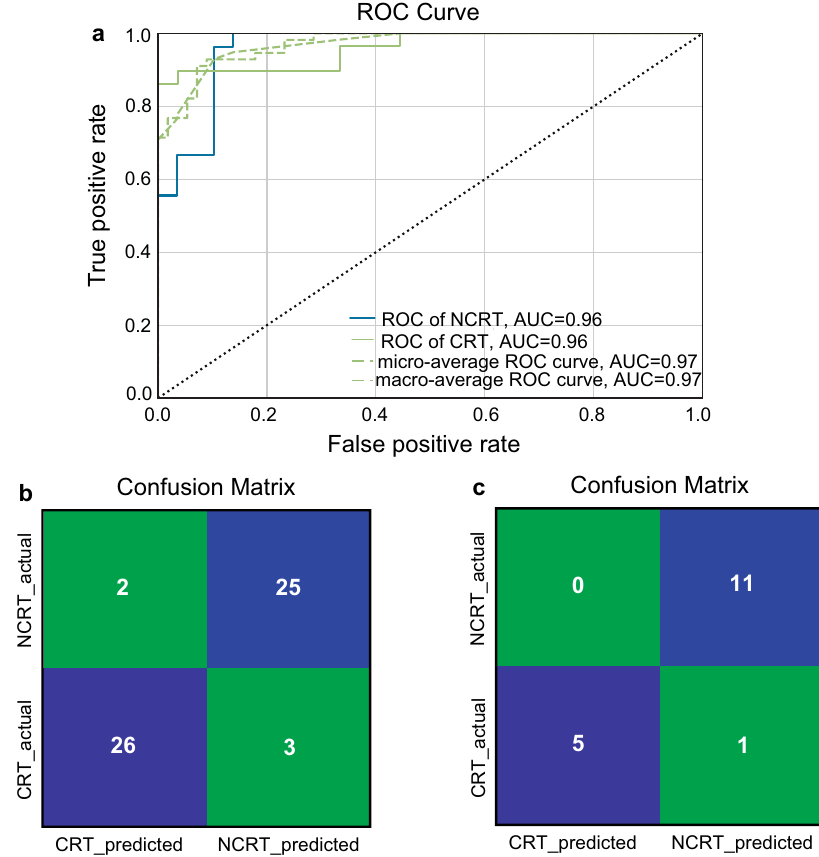
Fig. 4 Performance of the multilayer perceptron (MLP) model for provenance discrimination of WRT using 176 volatile features as the input dataset. a Receiver operating characteristic (ROC) curve of MLP where the model was trained using 5-fold cross-validation. b Confusion matrix of the MLP model on the test set. c Confusion matrix of the MLP model on the validation